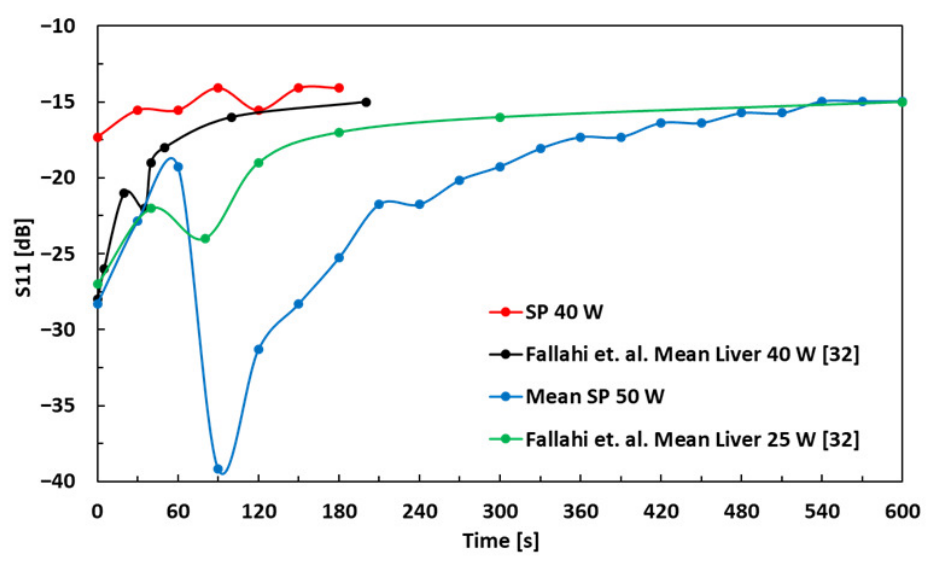
Figure 8. S 11 as a function of time for 25 W [32], 40 W [32] and 50 W MWA experiments. The ablation zone SAD in SP as a function of time for 50 and 80 W powers at 2.45 GHz is shown in Figure 9 and is also compared with MWA experiment in bovine liver, published in [33]. The ablation zone is elliptical with a short axis perpendicular to the microwave applicator. The measurement values denoted by green dots are taken from Figure 10 in [33], where an MWA experiment in bovine liver using 30 W power was conducted and analyzed, similarly to the method described here. The SP is cut open at the applicator puncture site after each experiment and MWA SAD perpendicular to the applicator channel is noted with an error of ±0.1 cm. The SAD of the ablation zone at 50 W is from 0.6 to 3.3 cm and for 80 W, 1.5 to 4.5 cm.